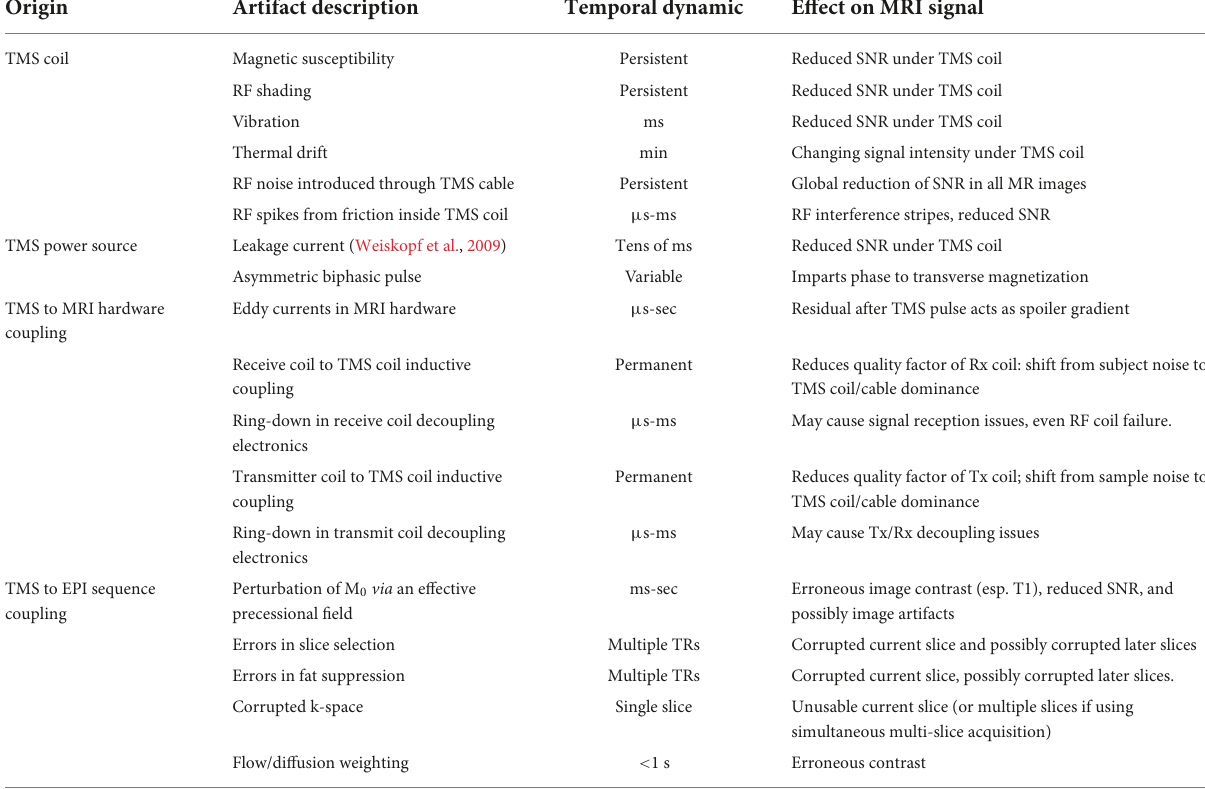
TABLE 2 MRI artifacts that may arise during data acquisition due to interactions with concurrent